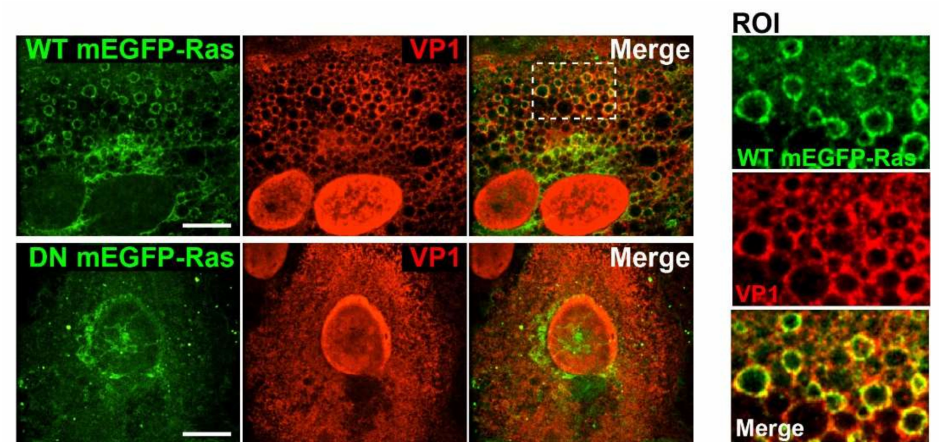
Figure 3. Ras signaling is required for vacuole formation. Fluorescence confocal microscopy images of SV40-infected CV-1 cells expressing wildtype (WT) or dominant-negative (DN) mEGFP-HRas (green): at forty-eight h.p.i., the localization of SV40 VP1 (red) was determined by immunostaining. The ROI depicts WT mEGFP-HRas accumulation at VP1-positive vacuoles. Single planes of z-stacks are shown. Scale bar, 10 µ